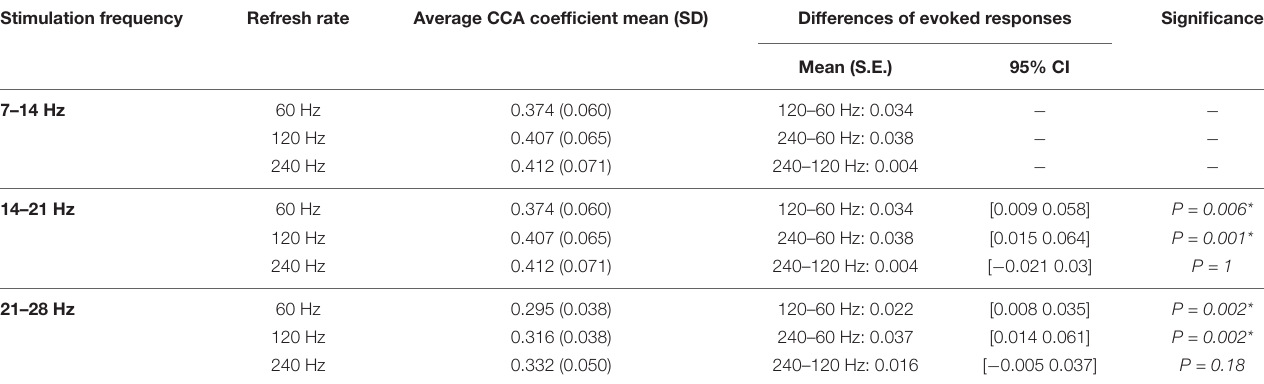
TABLE 2 | The post hoc comparison results of sinusoidal motion stimulation with different refresh rates. Stimulation